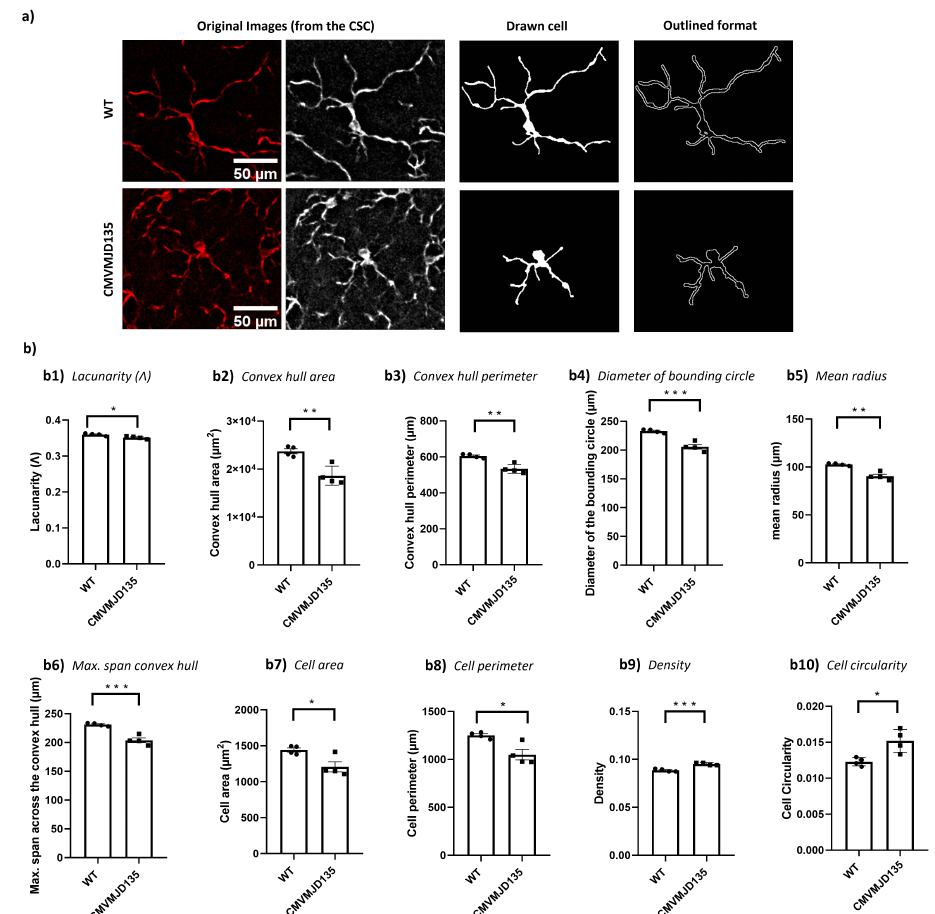
Figure 5. Microglia in the CSC of CMVMJD135 mice showed distinct activation-associated mor- phological features. ( a ) Representation of the process to prepare the images for fractal analysis of microglia morphology. These images show differences regarding the convex hull area, the mean radius, and the maximum span across the convex hull in microglia from CMVMJD135 mice. ( b ) Quan- tification of the morphometric features associated with heterogeneity of the shape: ( b1 ) lacunarity. Associated with cell’s size: ( b2 ) convex hull area, ( b3 ) convex hull perimeter, ( b4 ) diameter of the bounding circle, ( b5 ) the mean radius, ( b6 ) the maximum span across the convex hull, and ( b7 ) the cell area. Associated with cell’s surface: ( b8 ) cell perimeter. Associated with soma thickness: ( b9 ) density and ( b10 ) cell circularity. Data of all these features were obtained from 310 microglial cells from WT mice ( n = 4) and 389 microglial cells from 34-week-old CMVMJD135 mice ( n = 4) of the CSC. Data are presented as mean + SEM (Student’s t -test). *, **, ***, represent p < 0.05, p < 0.01 and p < 0.001, respectively. Scale bar: 50 µ